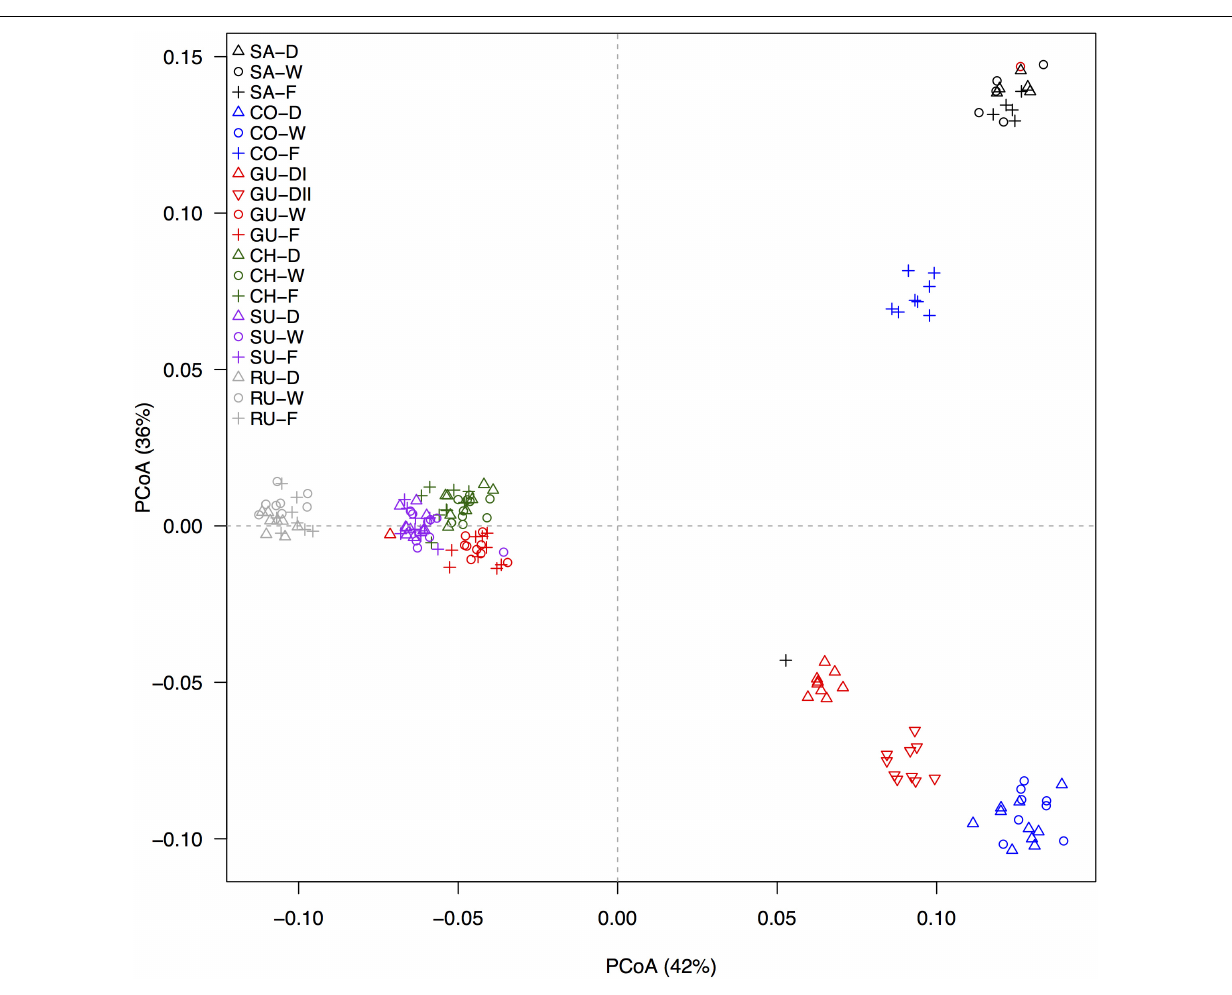
FIGURE 2 | Differentiation, as revealed by principal coordinates analysis (PCoA), based on 1,273 GBS-derived SNP markers. Ecotypes are labeled by different symbols as follows: caulescent populations from cloud forest (+), caulescent populations from wind-sheltered well-irrigated depressions (o) and acaulescent populations from wind-exposed drier slopes ( (cid:77) ), and abbreviated in the figure legend according to the habitat as forest (F), wet (W) and dry (D), respectively. Localities are identified by different colors and coded as in Figure 1 . The percentage of explained variation by each axis is shown within parenthesis in the label of the corresponding